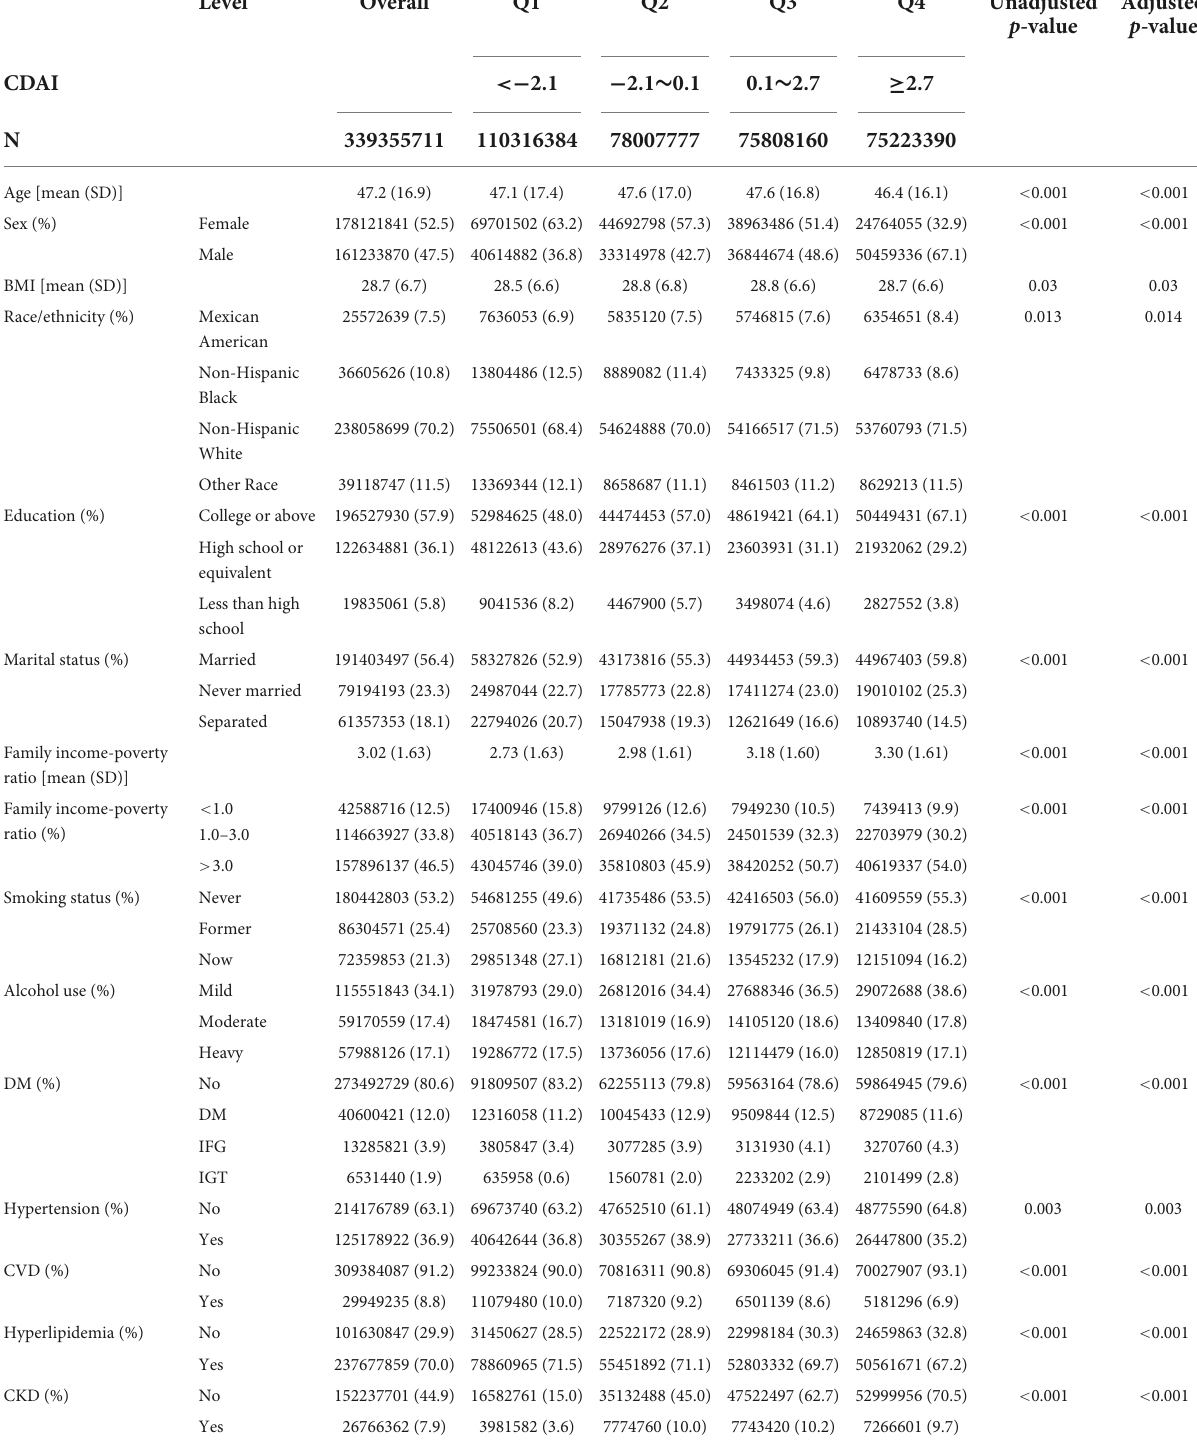
TABLE 1 Weighted characteristics of the study participants by the quartiles of composite dietary antioxidant